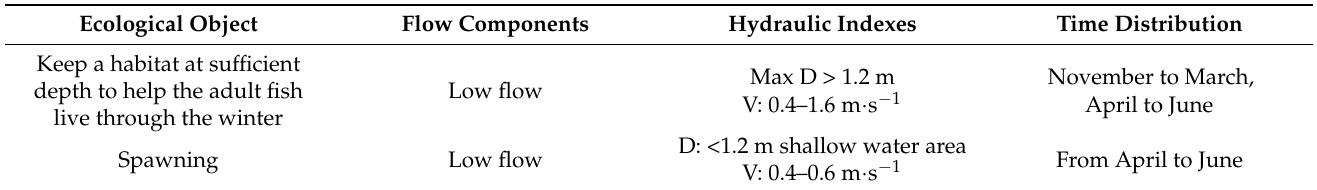
Table 1. Flow components and hydraulic indicators related with ecological demands of Silurus lanzhouensis . Ecological Object Flow Components Hydraulic Indexes Time Distribution Keep a habitat at sufficient Max D > 1.2 m depth to help the adult fish Low flow V: 0.4–1.6 m · s − 1 live through the winter D: <1.2 m shallow water area Spawning Low flow V: 0.4–0.6 m · s −